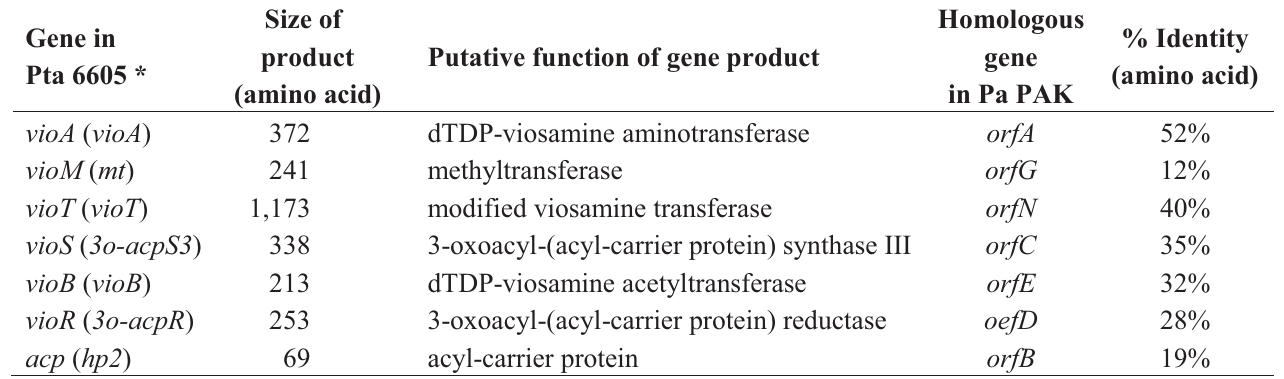
Table 1. Similarities of open reading frames (ORFs) in viosamine cluster in Pta 6605 to those in P. aeruginosa (Pa) PAK